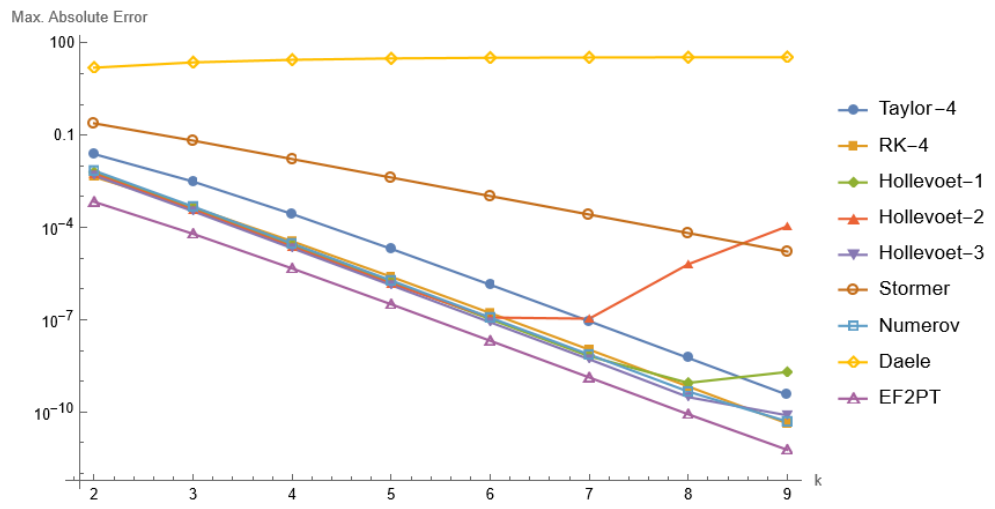
Figure 3. Maximum absolute errors for Problem 2 as a function of the stepsize h = 2 − k , k = 2 ( 1 )